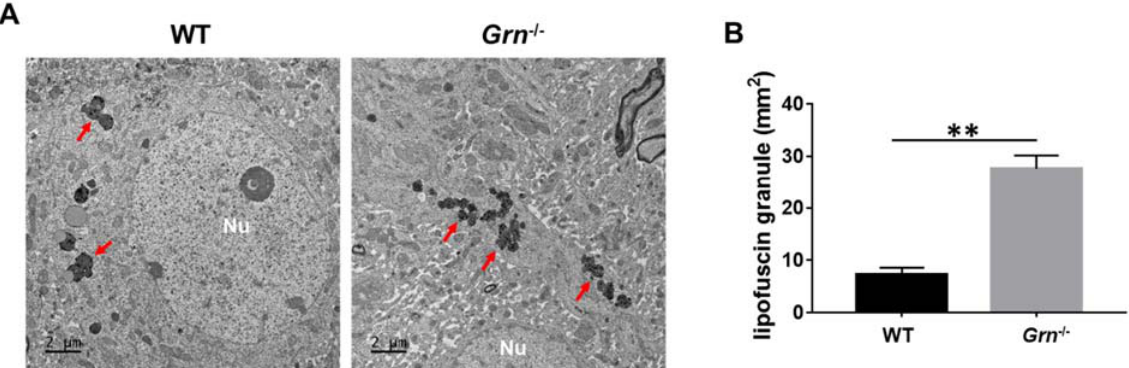
Figure 8. PGRN deficiency led to the accumulation of lipofuscin in a 17-month-old brain. Transmis- sion electron microscopy was used to observe the lipofuscin granules in the brain of 17-month-old WT and Grn − /– mice. ( A ) Lipofuscin granules in the brain tissue (red arrow) of WT and Grn − /– mice. ( B ) Average number of lipofuscin granules detected per mm 2 . Nu: Nucleus. Scale bar: 2 μ m. n = 3. Data presented as mean ± SD. ** p < 0.01.